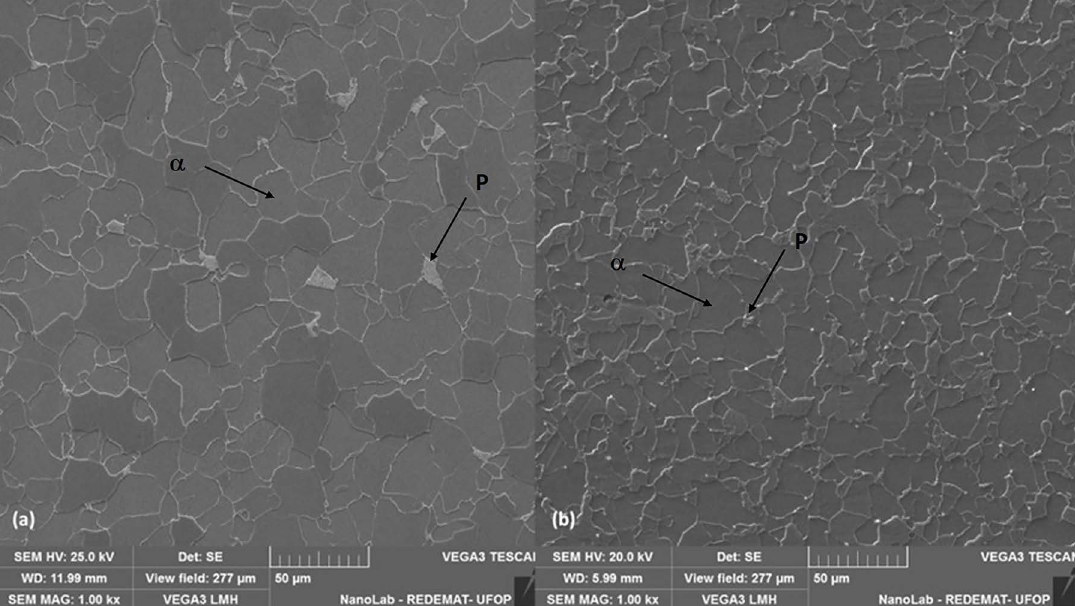
Figure 8. SEM micrographs of microstructures of (a) steel A and (b) steel B cooled with 1ºC/s - 1000X (α-ferrite, P-